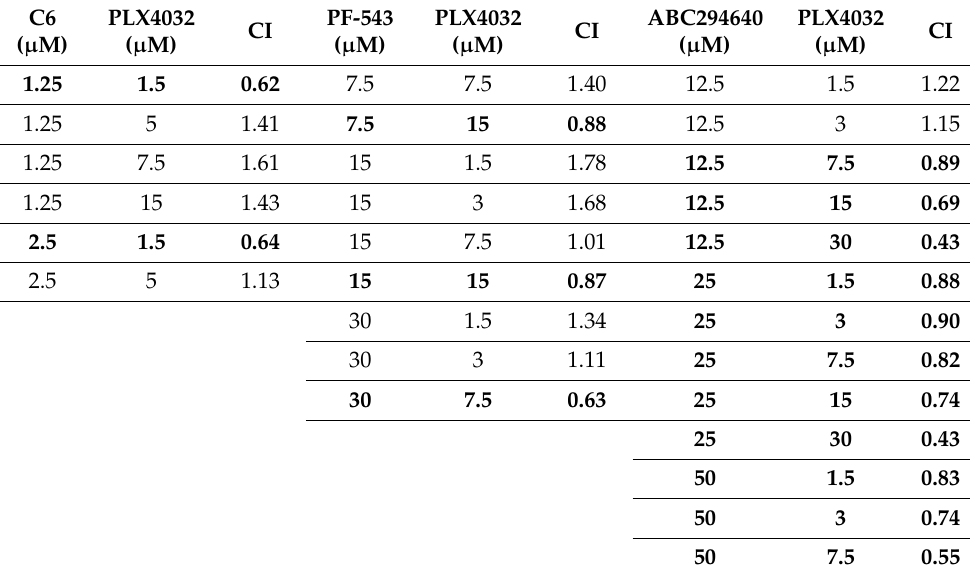
Table 2. Combined therapeutic effects of either C6 ceramide, sphingosine kinase 1 inhibitor PF- 543 or sphingosine kinase 2 inhibitor ABC294640 and vemurafenib in vemurafenib-resistant RKO colon cancer cell line. The combination index (CI) was calculated for each drug combination, where CI < 1 indicates synergy; CI = 1 indicates additivity; and CI > 1 indicates antagonistic effects. Drug combinations exhibiting synergistic effect were shown in